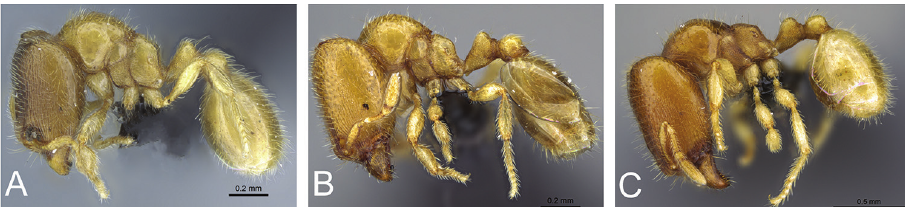
In full-face view, mandible with six teeth; in profile, combined outline of dorsal surface of peduncle and anterior face of node medially concave; an- terodorsal corner of node more broadly rounded, petiole node longer (PNL 0.12–0.15); petiole and postpetiole with all hairs suberect to subdecumbent (Fig. 7C); dorsum of propodeum with more than ten long erect to suberect hairs ............................................................................................ C. hiragasy – In full-face view, mandible with five teeth; in profile, combined outline of dorsal surface of peduncle and anterior face of node nearly flat (Fig. 7A, B); anterodorsal corner of node convex or narrowly rounded, petiole node short (PNL 0.08–0.11); dorsum of propodeum with fewer than ten erect or su- berect hairs ................................................................................................. 7 7 In full-face view, dorsum of head with well defined longitudinal rugae later- ally, and smooth and shiny middle area; in profile gaster with abundant long suberect hairs; distance from propodeal spiracle to declivity less or same as the diameter of the spiracle (Fig. 7A) .................................................. C. tanana – In full-face view, dorsum of head smooth and shiny or with fine longitudinal rugae laterally, smooth and shiny frons; in profile gaster with short decum- bent to subdecumbent hairs and long subdecumbent to suberect hairs; dis- tance from propodeal spiracle to declivity same or greater than the diameter of the spiracle (Fig. 7B) ..................................................................... C. bara